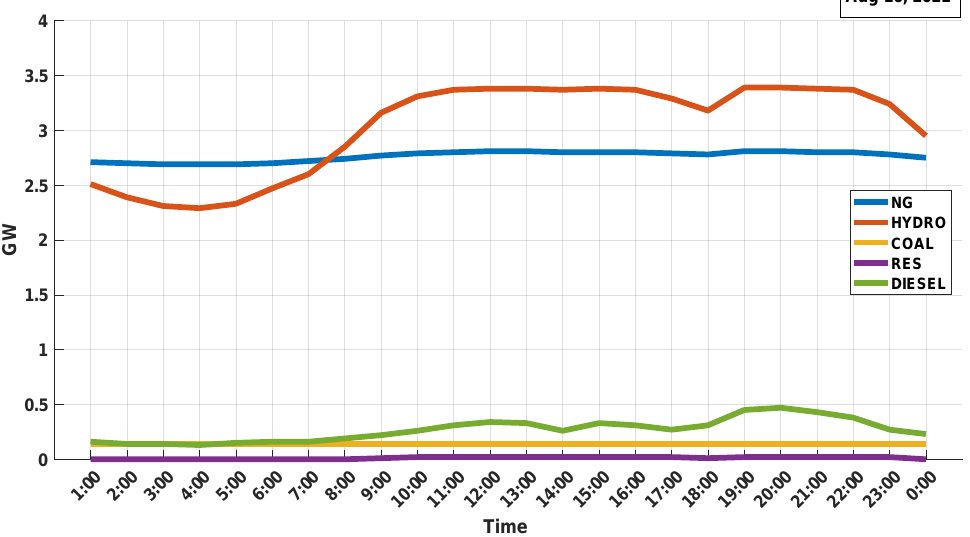
Figure 20. Contribution to demand by type of technology—stage